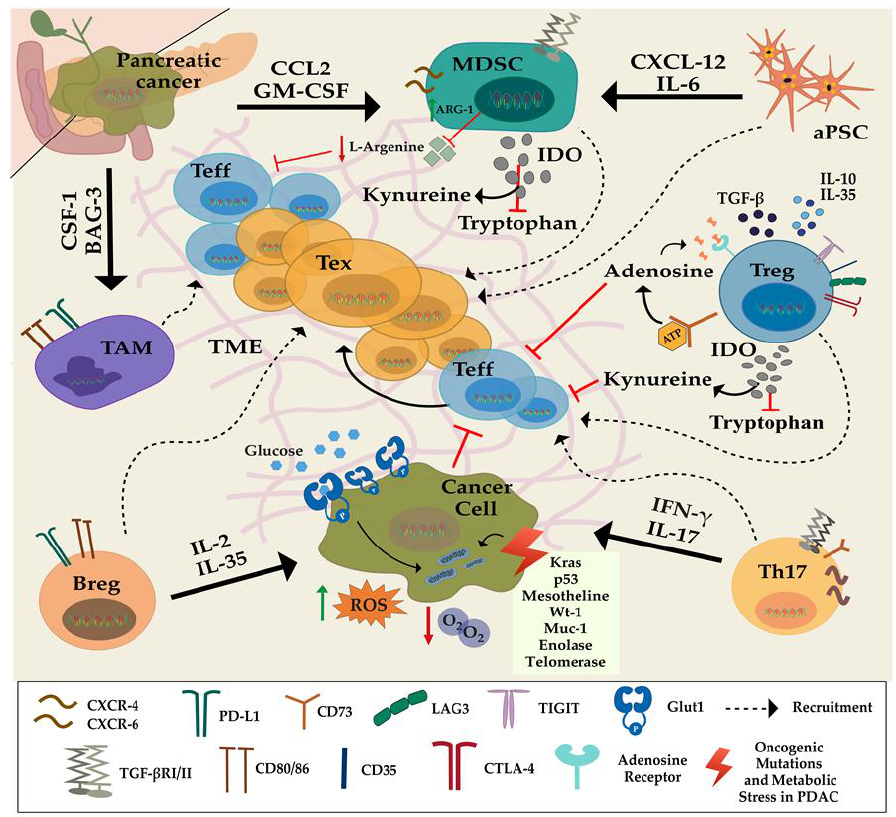
Figure 1. Cellular and molecular immunomodulatory factors of T-cell exhaustion in pancreatic cancer in the tumor microenvironment: myeloid-derived suppressor cells (MDSCs) and tumor-associated macrophages (TAMs) inhibit T-cell function directly and indirectly through tumor-derived proteins, such as Granulocyte-macrophage colony-stimulating factor (GM-CSF), C-C Motif Chemokine Ligand 2 (CCL2), Colony Stimulating Factor 1 (CSF1), and Bcl2-associated athanogene 3 (BAG3). Activated pancreatic stellate cells (aPSCs) recruit suppressive immune cells and impair antitumor cells in the stroma and, via secretion of interleukin 6 (IL-6) they induce immune checkpoints on T cells in a C-X-C motif chemokine 12(CXCL12)-dependent manner. They also promote the proliferation of MDSCs and IL-35 secreting Bregs. Intratumoral Tregs secrete suppressive cytokines IL-10, IL-35, tumor growth factor β (TGF- β ), thereby inducing T-cell dysfunction to impair Te ff cell proliferation. Tregs also elevate kynurenine concentration and reduce available tryptophan required for e ff ector Tcell’ e ff ector function